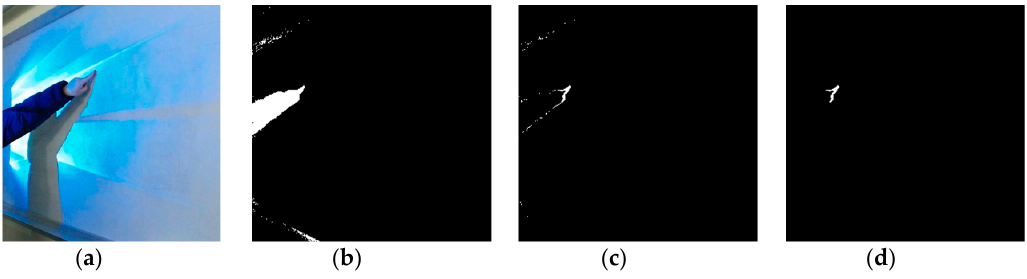
Figure 6. Touch region detection: ( a ) original picture; ( b ) touch object detection; ( c ) touch region detection with noise; ( d ) touch region detection without noise.